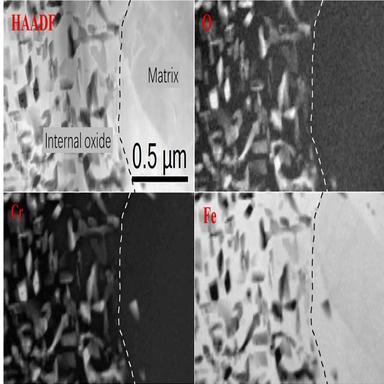
The TEM HAADF image and the EELS analysis results at the matrix-internal oxide layer interface of T91 after exposure in SCW at 600 ◦C for 100 h.